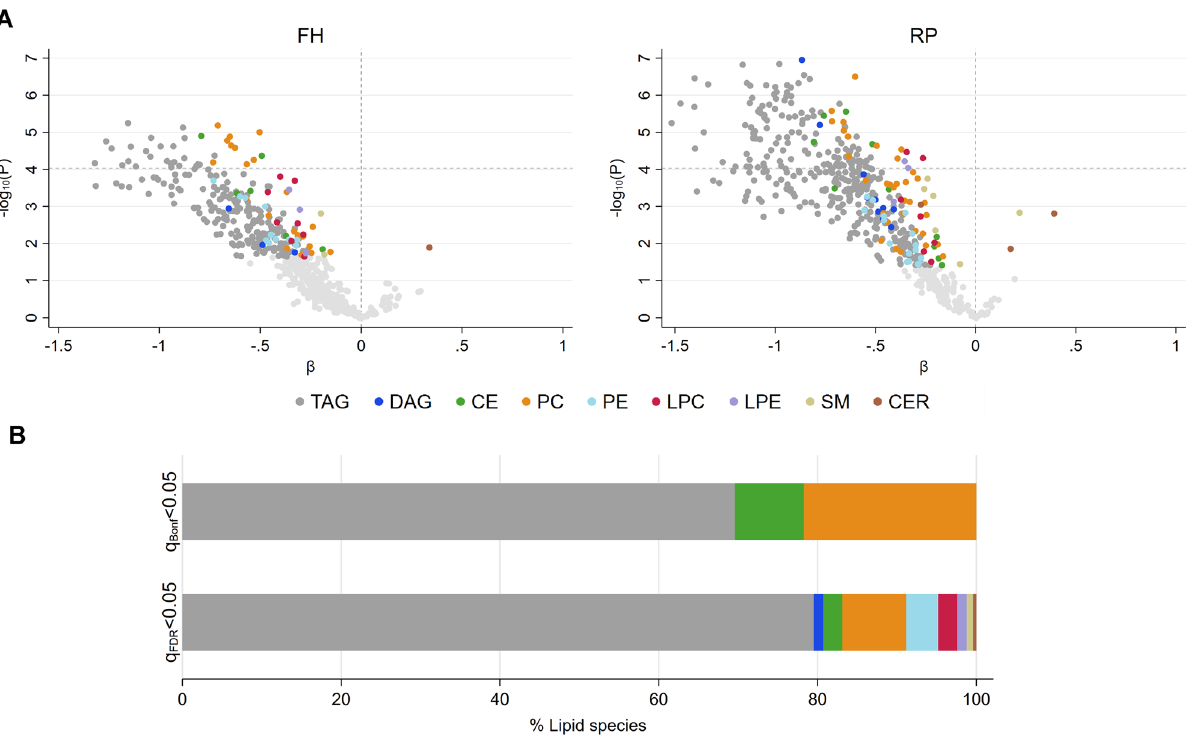
Figure 1. Plasma lipid metabolite differences between cases and controls in Fred Hutch (FH) and Roswell Park (RP) patient cohorts. Log 2 metabolite concentrations were regressed on case status with adjustment for age and BMI. ( A ) Volcano plots depicting estimated beta (β) coefficients and − log 10 P values for 546 individual lipid metabolites (left: FH, right: RP). Species satisfying FDR q < 0.05 are color-coded by lipid class, as indicated, with the remainder shown in light gray. Dashed horizontal line marks the Bonferroni-corrected threshold for statistical significance: − log 10 (0.05/546) = 4.04. ( B ) Lipid class assignments of species reaching q Bonf < 0.05 (n = 23, top), or q FDR < 0.05 (n = 249, bottom), in both